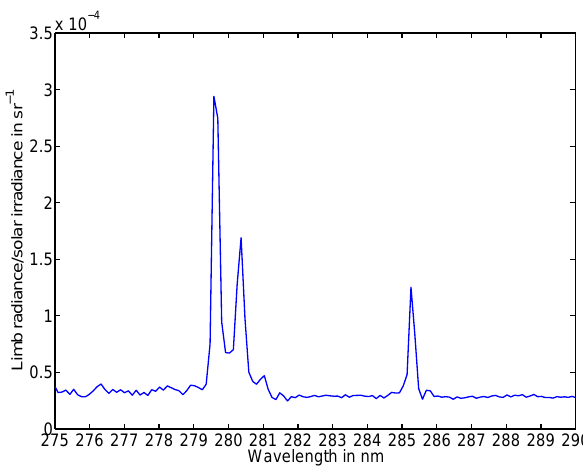
| multiple scattering − single scattering | Fig. 2. Relative difference of sim- min ( multiple scat ., single scat .) ulated spectra for multiple scattering for the wavelength region of the Mg/Mg + lines. The simulations where performed with SCIA- TRAN for an equatorial scenario. This and other scenarios with, e.g., an ozone layer of 150 Dobson units, show only minor differ- ences of less than 1% between single and multiple scattering. Mul- tiple scattering thus can be